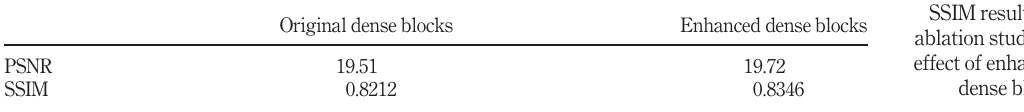
Table 1. Average PSNR